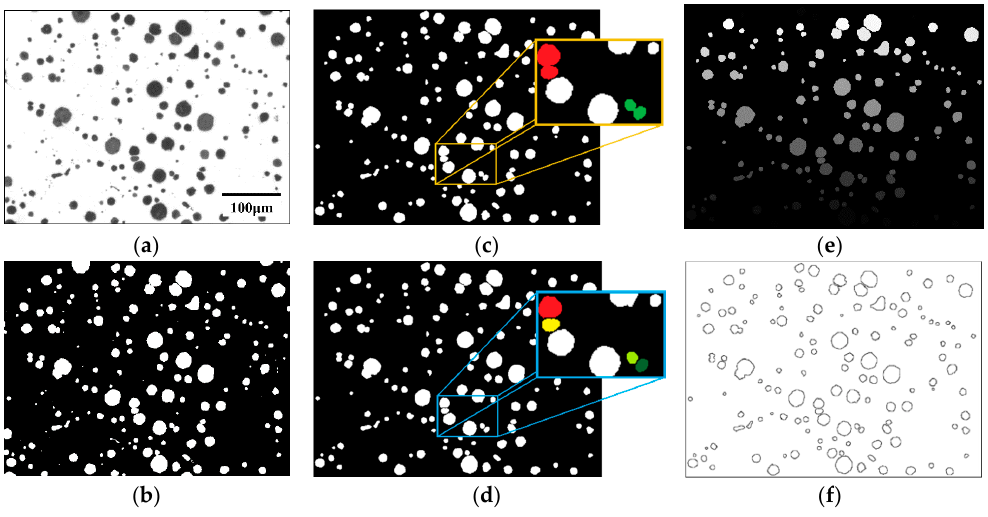
Figure 6. ( a ) Original micrography; ( b ) Binarized image; ( c ) Image without the edge nodules nor the smallest nodules; ( d ) Image with overlapped nodules separated; ( e ) Labeled image; and, ( f ) Graphite nodules contours